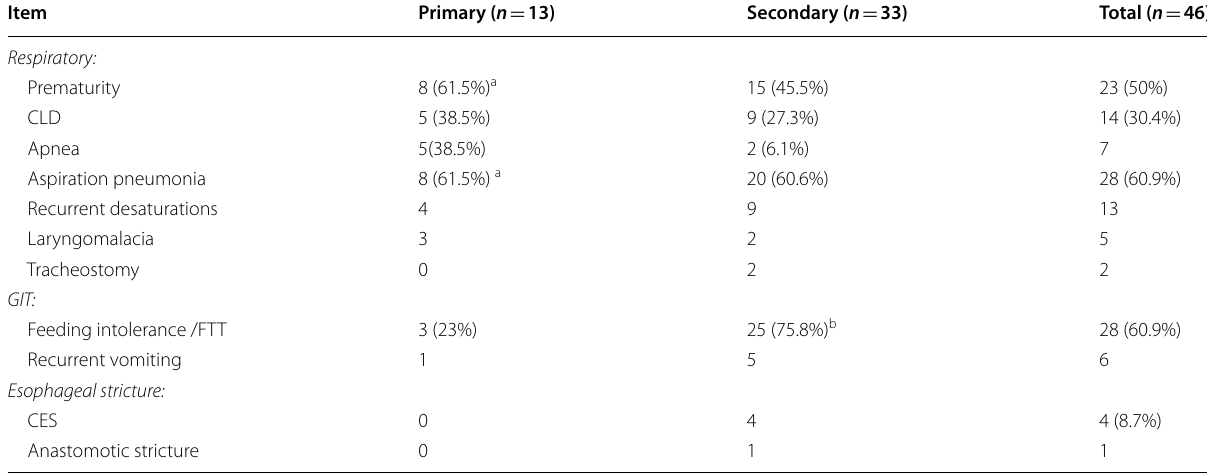
a Main presentation for the primary group b Main presentation of the secondary group